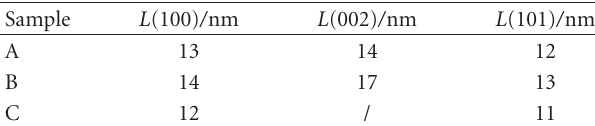
Table 1: The GIXRD data of the ZnO thin films: crystallite sizes, L ( hkl ) , estimated from (100), (002), and (101) reflections. Sample